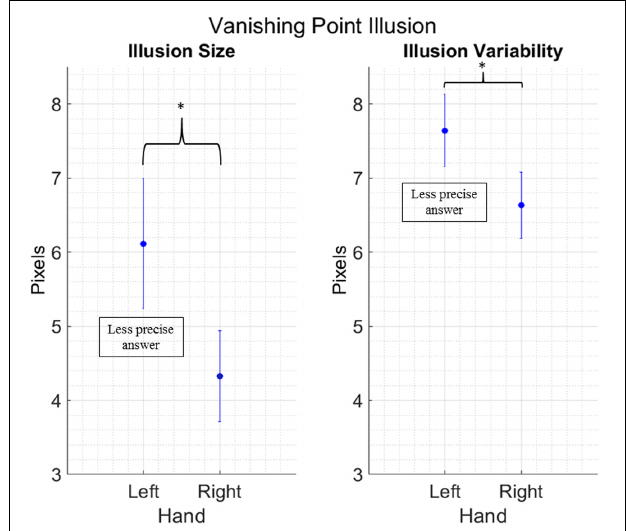
FIGURE 3 | Main effect of Condition in the Poggendorff Illusion. Data are collapsed between the right and the left hand, since this factor was not significant in the main analysis Vertical bars represent standard error of the mean. Illusion size represent the dimension of the displacement in alignment. Negative values indicate the displacement is downward. Stars indicate a significant difference at p < 0.01.